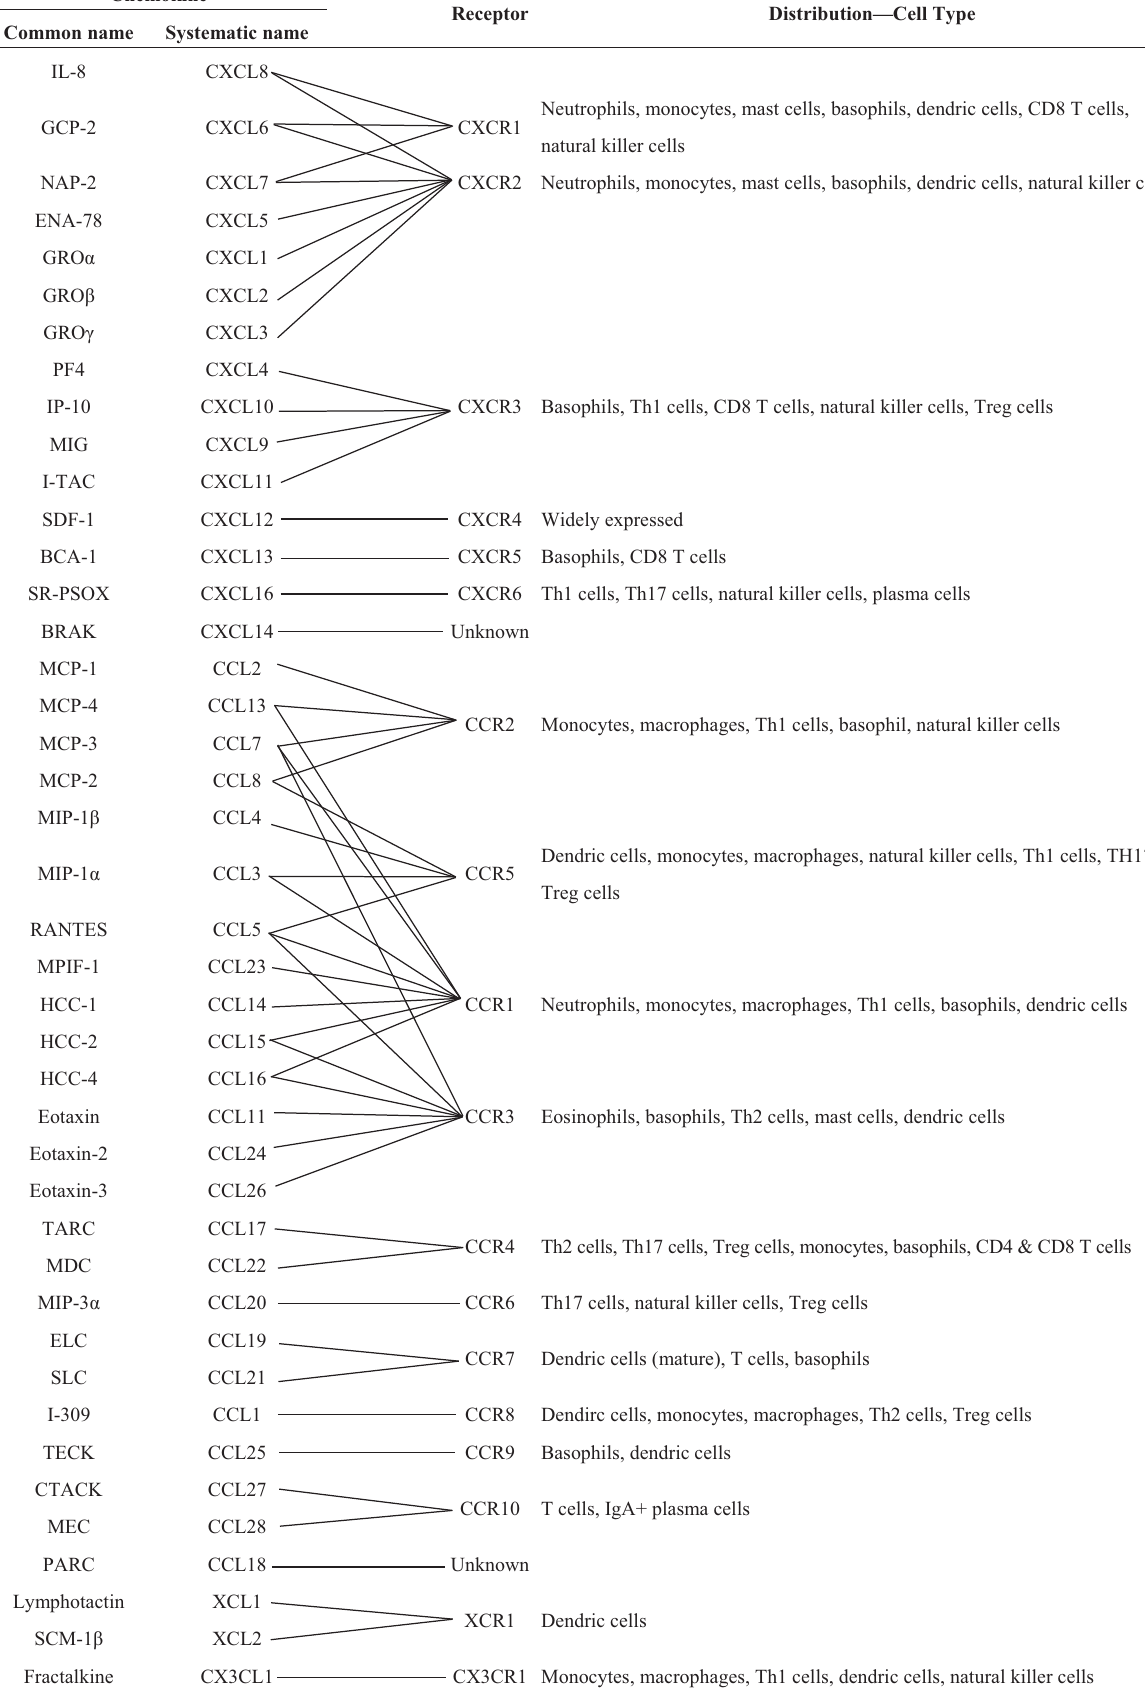
Table 1. Chemokines and chemokine